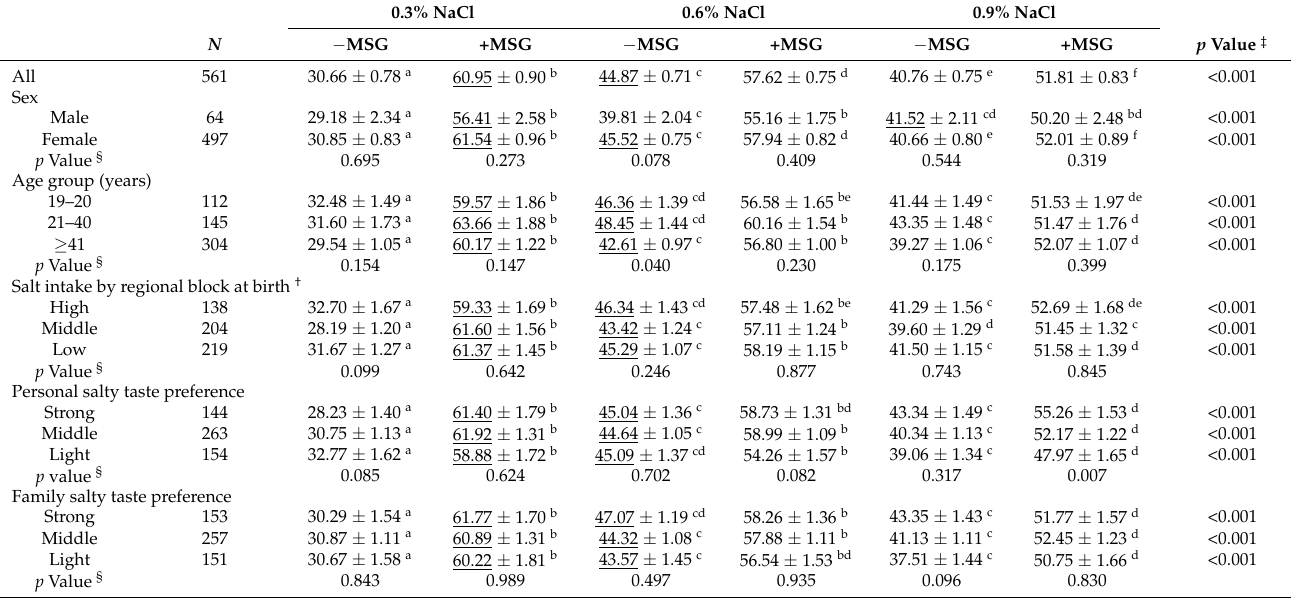
Table 4. Palatability VAS ratings by sex, age, salt intake by regional block at birth, and salty taste